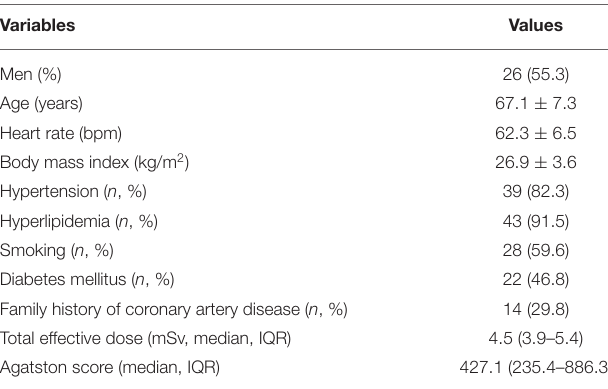
TABLE 1 | Baseline patient characteristics ( n =